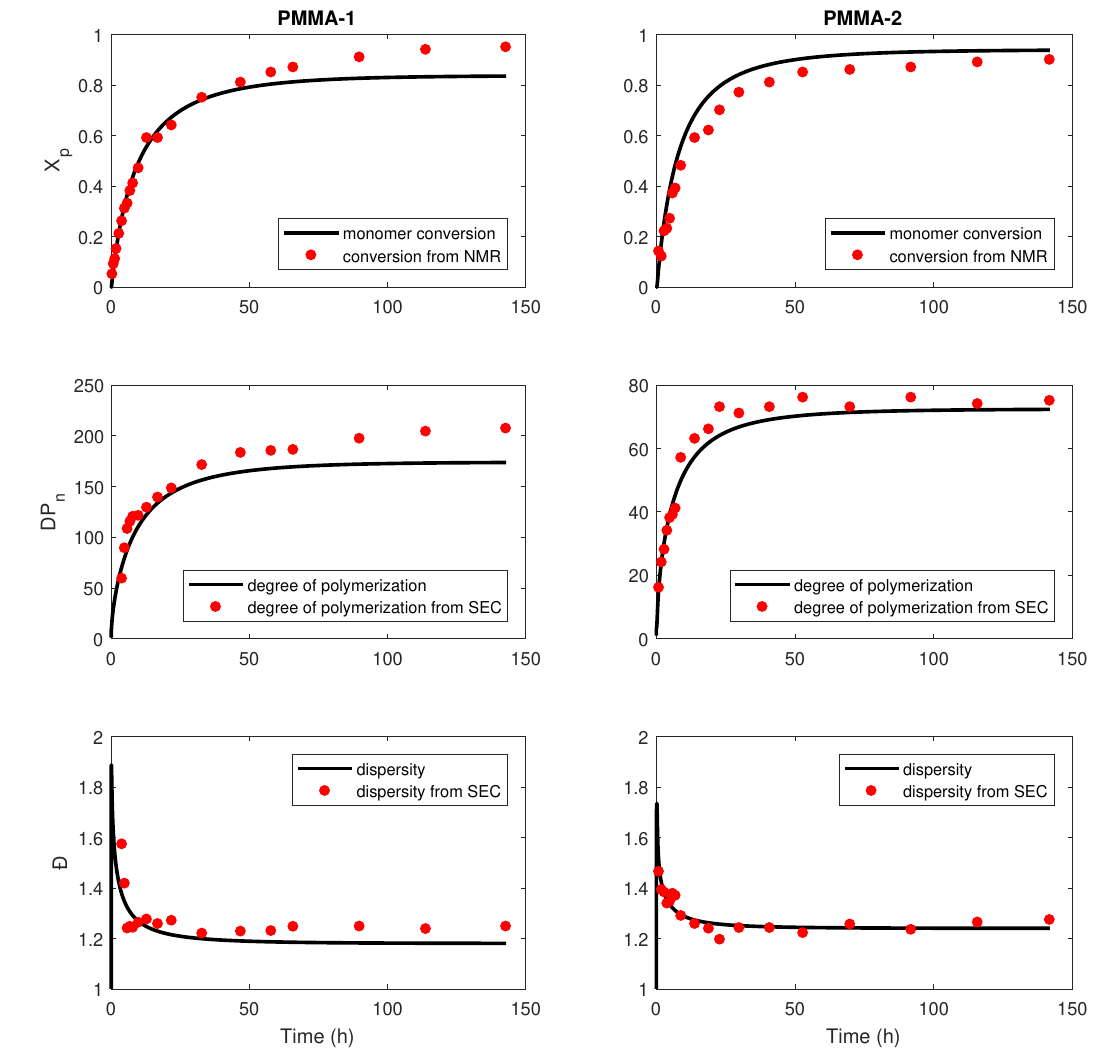
Figure 7. First row: conversion of MMA into polymer with respect to time; second row: evolution of number average degree of polymerization with respect to time; third row: evolution of dispersity with respect to time; Left: PMMA-1; Right: